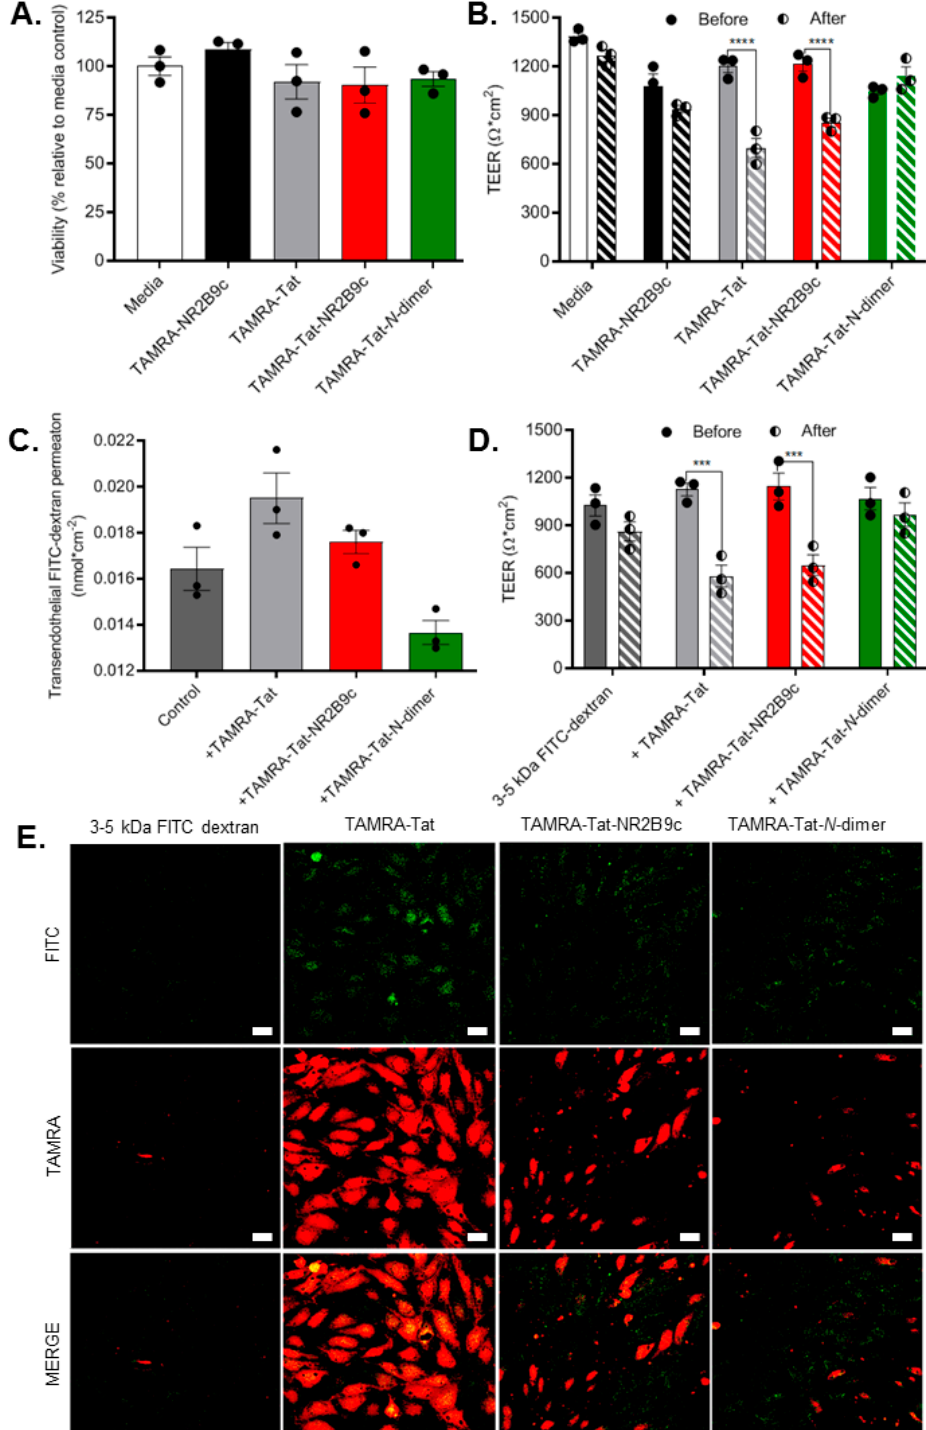
Figure 2. ( A ) The cellular viability was assessed following application of 100 µ M TAMRA-NR2B9c, TAMRA-Tat, TAMRA-Tat-NR2B9c, or TAMRA-Tat- N -dimer to the in vitro BBB model for 3 h. ( B ) The barrier integrity was evaluated by measuring transendothelial electrical resistance (TEER) before and after application of the peptides (100 µM). ( C ) Transport of 3–5 kDa FITC-dextran was quantified after 3 h of incubation on the in vitro BBB model alone (1 mg/mL; control) or in the presence of the peptide (100 µ